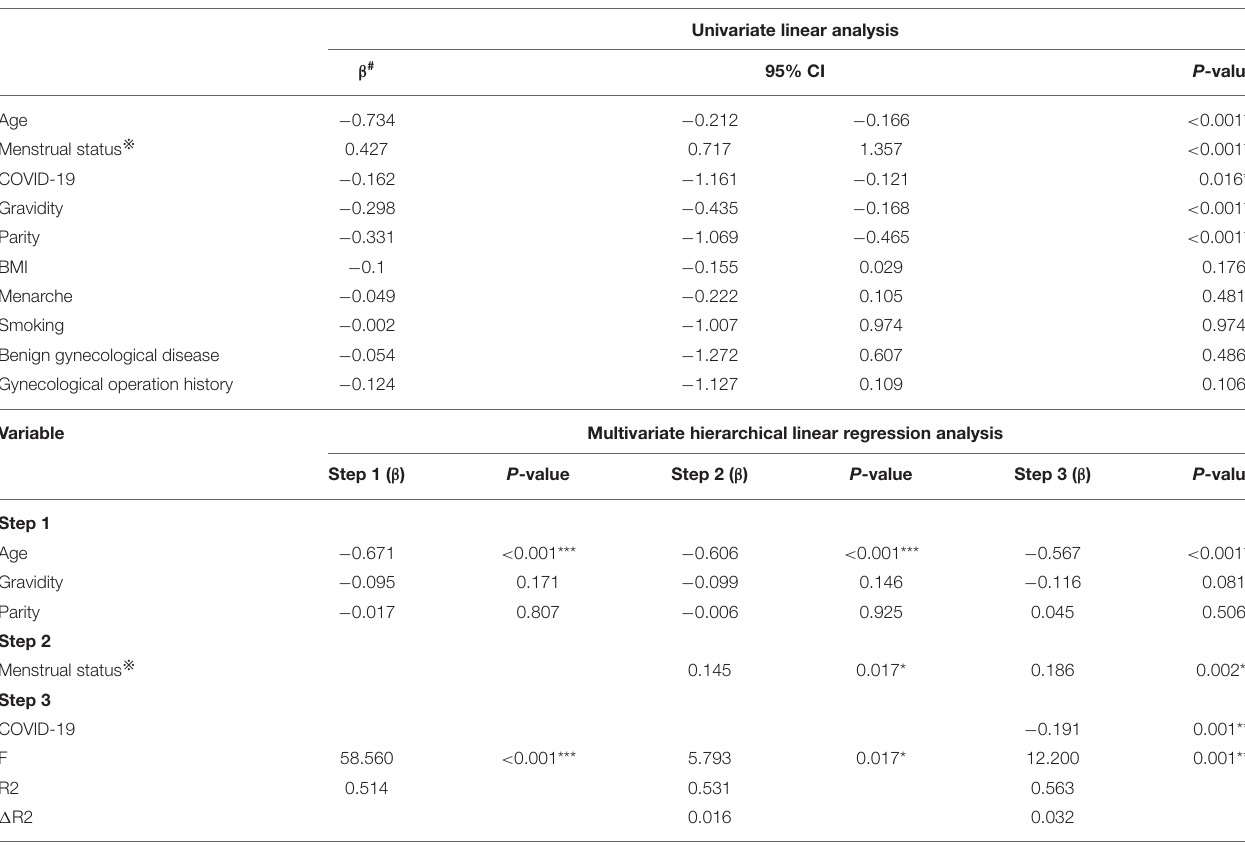
TABLE 2 | Linear regression for association of COVID-19 disease with ovarian reserve